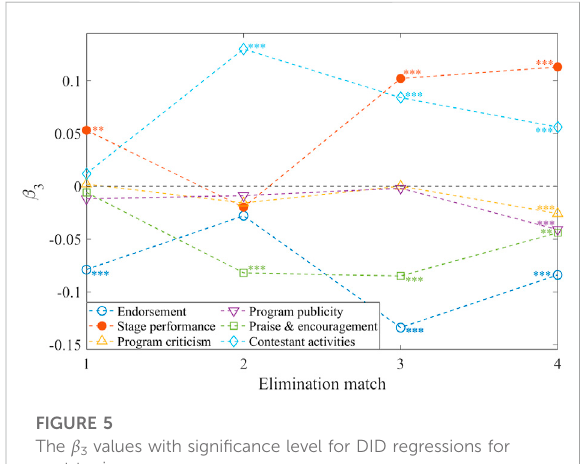
FIGURE 5 The β 3 values with signi fi cance level for DID regressions for post